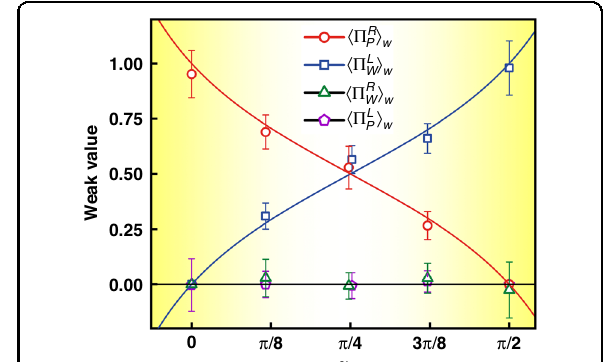
Fig. 4 Comparison between the theoretical prediction and experimental results. The curves with different colors represent the corresponding theoretical weak value, and points of different shapes represent the groups of experimental data. Error bars for α are extremely small and near